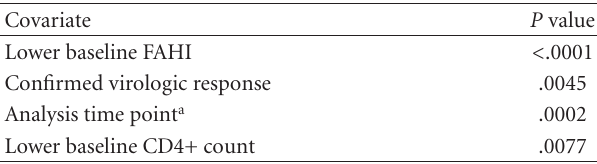
Table 3: Factors associated with improvements in total FAHI score over 48 weeks in the final multivariate